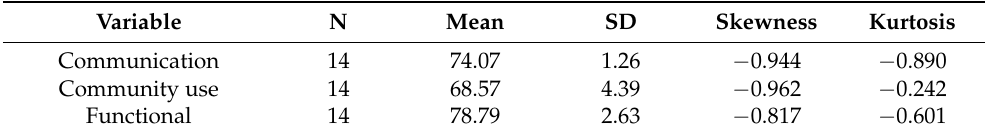
Table 2. Descriptive statistics * for all the variables included in the